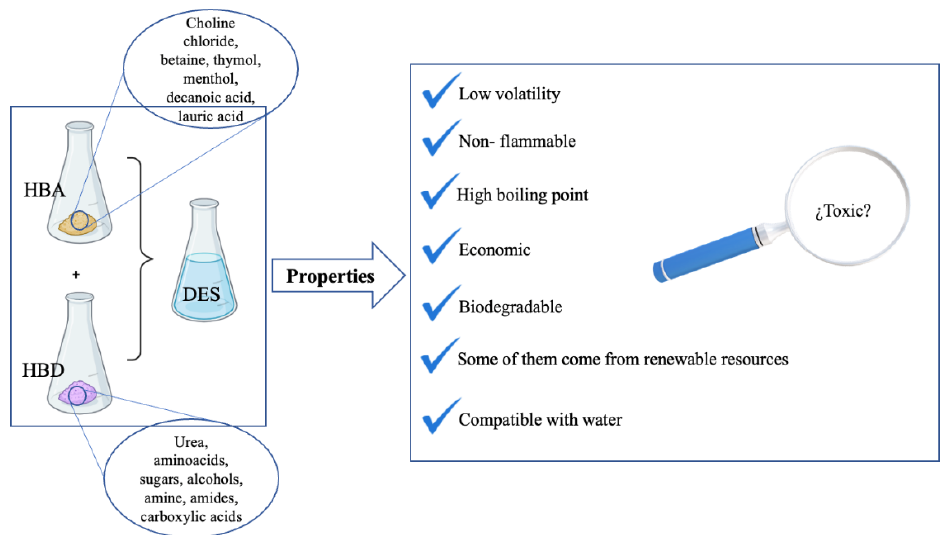
Figure 2. Properties of deep eutectic solvents.